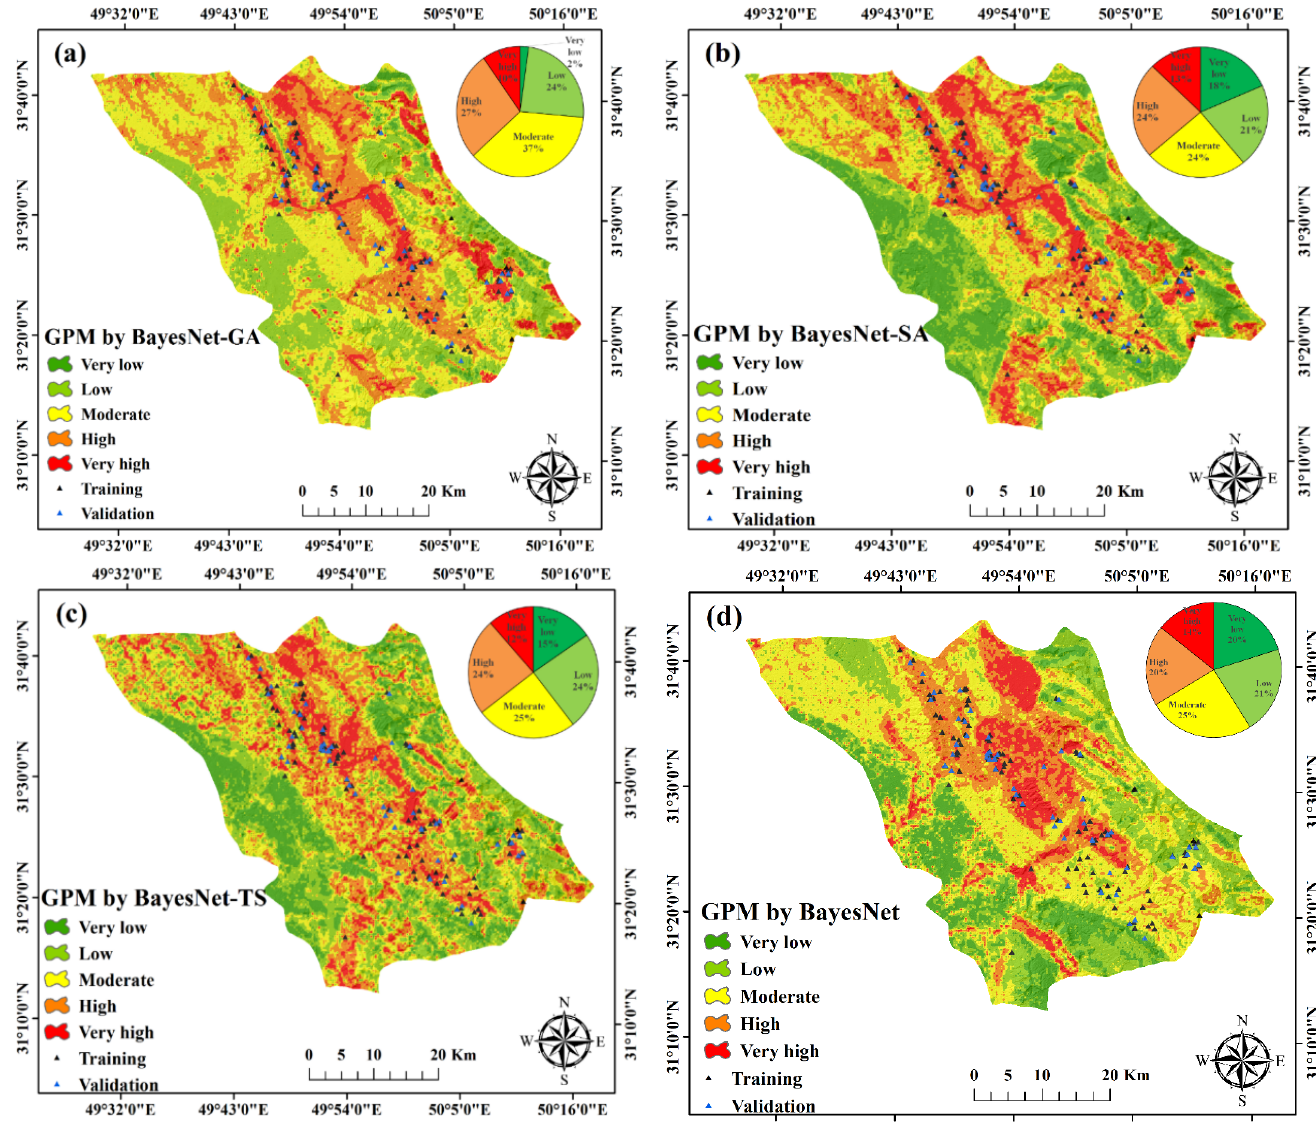
Figure 6. GPM by: ( a ) BayesNet-GA, ( b ) BayesNet-SA, ( c ) BayesNet-TS, ( d ) BayesNet models.